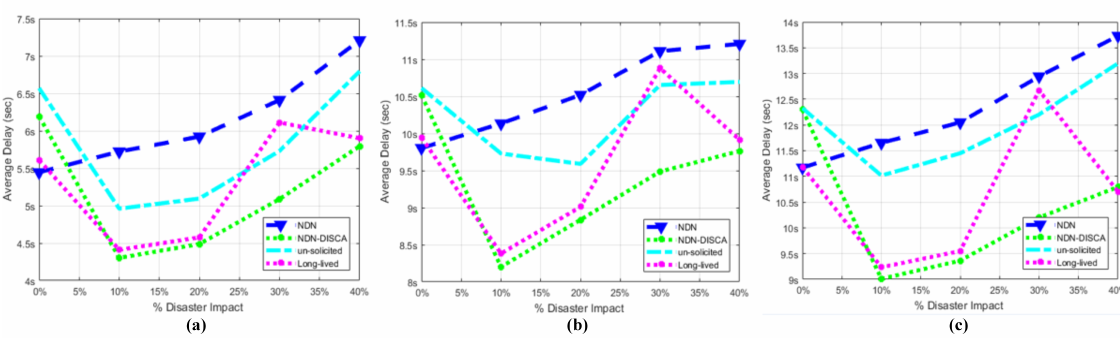
Figure 7. Overall Message (Transmission + Propagation) Delay of SC When Fire Disaster is Being Held in SL-1 w.r.t Three Partition Chunks ( a ) SL-2, ( b ) SCL, ( c ) SFR.